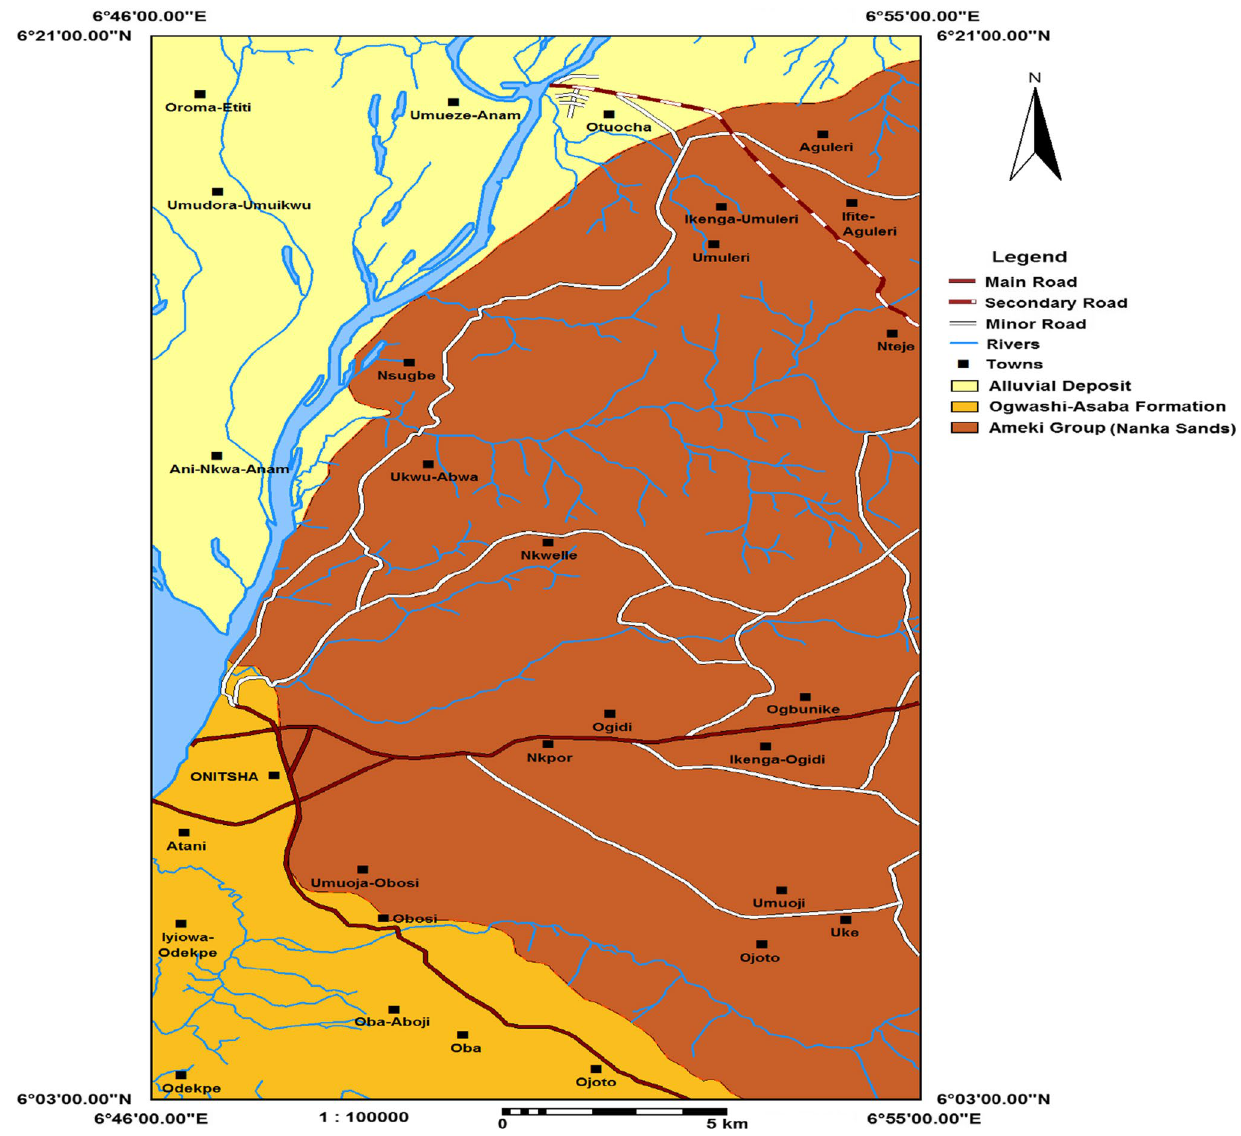
Fig. 1 Geologic map of the study